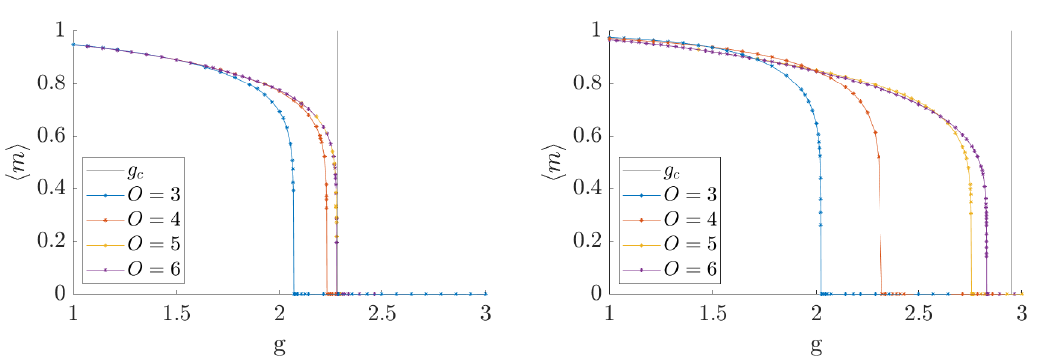
Figure 7: Results for the 2-D transverse-field Ising model at fixed T = 1.5 (top) and T = 0.5 (bottom). The magnetisation is calculated for MPS bond dimension χ = 45. The figures show the magnetisation curve for different orders O of the cluster-TNO. For order O = 6, virtual level ‘3’ is truncated at bond dimension 20. The black lines denote the “exact” critical temperatures, taken from Ref. [ 23 ]